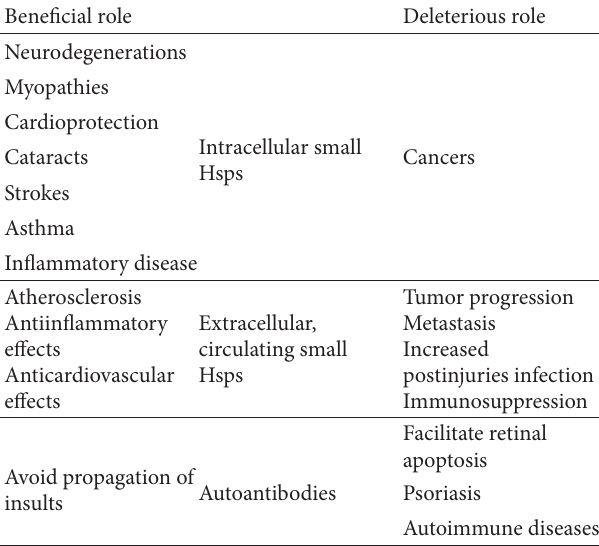
T 1: Bene�cial and deleterious roles of small Hsps. Schematic illustration of the dual role of intracellular and extracellular small Hsps as well as autoantibodies against these